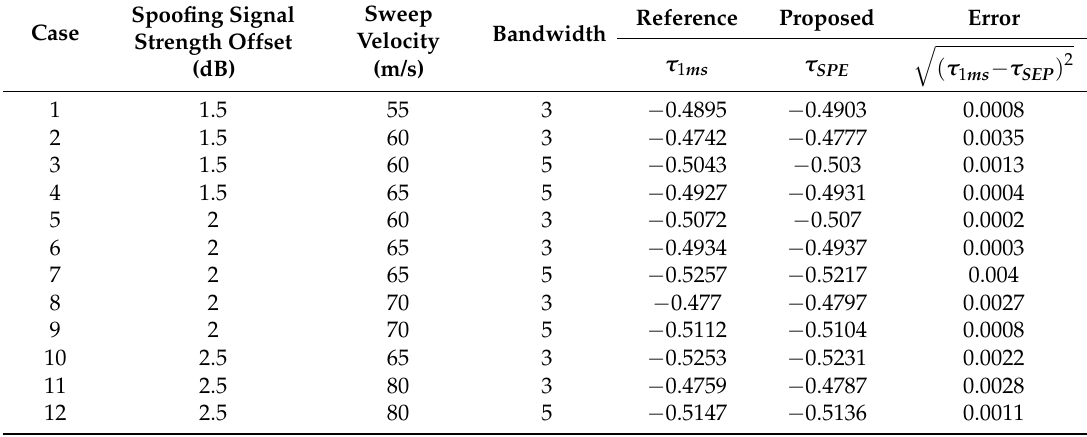
Table 5. Various spoofing parameters and τ results in case of using original DLL and